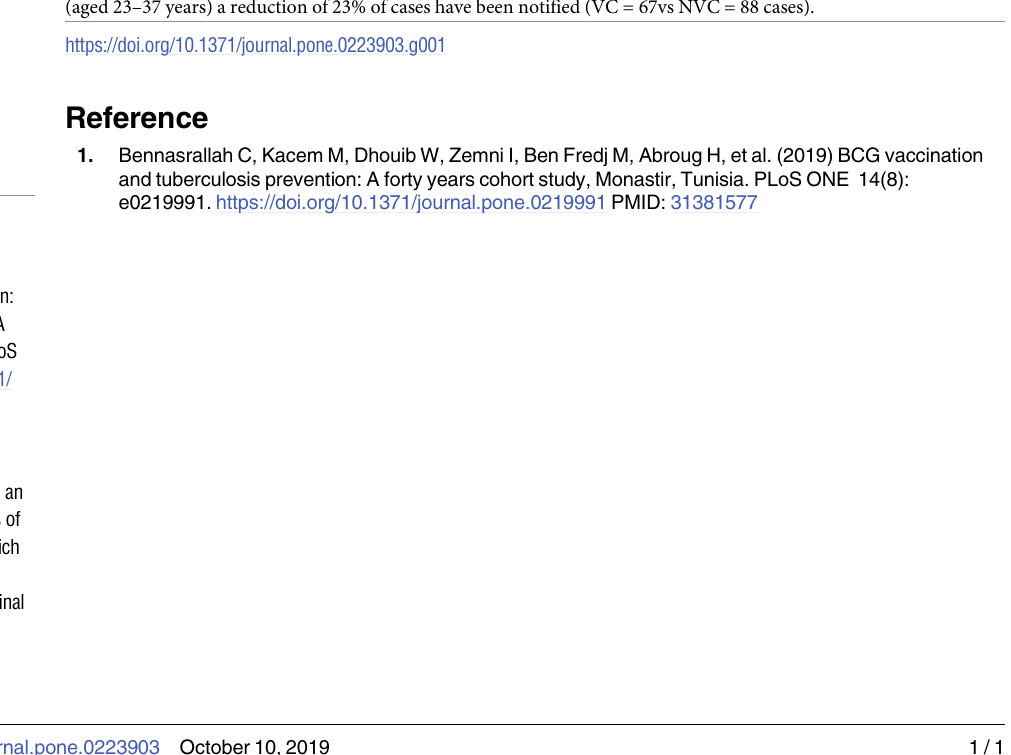
Fig 1. Age distribution of pulmonary tuberculosis cases according to immunization Status. In transient cohort (aged 23–37 years) a reduction of 23% of cases have been notified (VC = 67vs NVC = 88